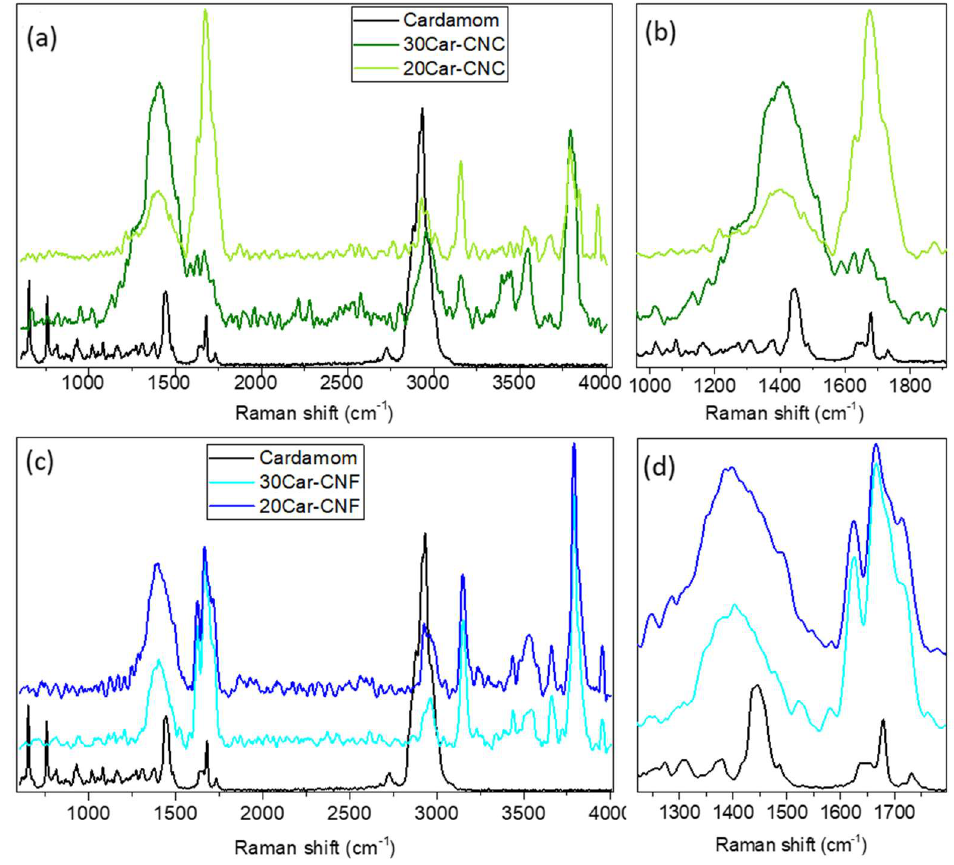
Figure 5. FT-Raman spectra of cardamomum essential oil and its CNC-stabilized emulsions ( a ) full-spectrum and zoom in the region ( b ) 1350–1900 cm −1 , and CNF-stabilized emulsions ( c ) full-spectrum and zoom in the region ( d ) 1350–1900 cm −1 .